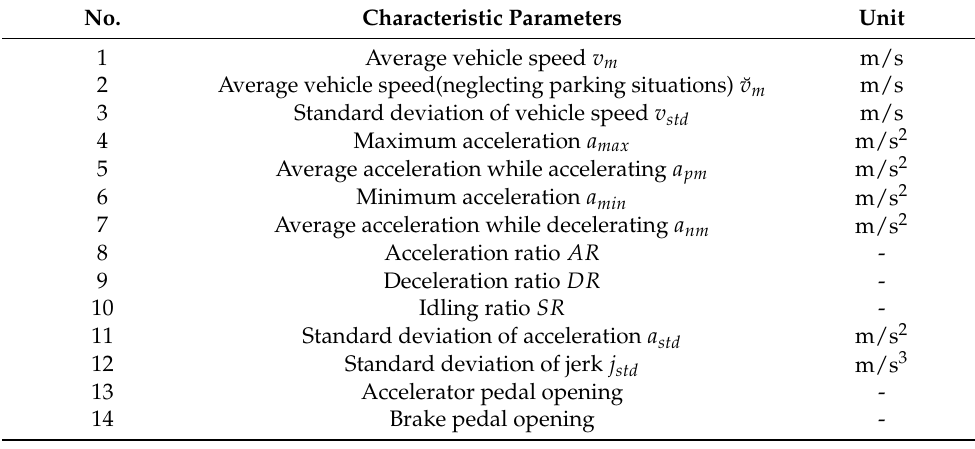
Table 2. The list of selected characteristic